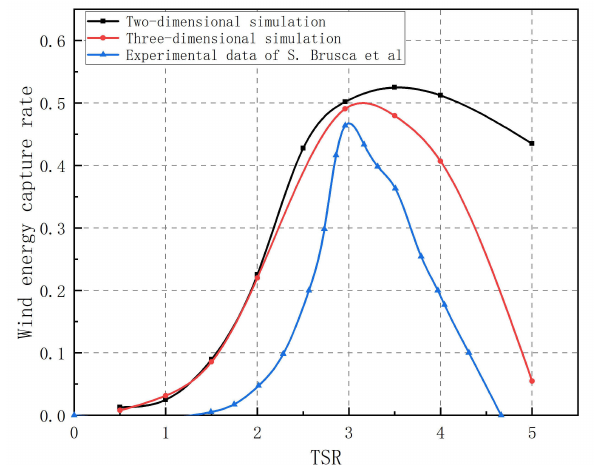
Figure 23. Wind energy capture rate